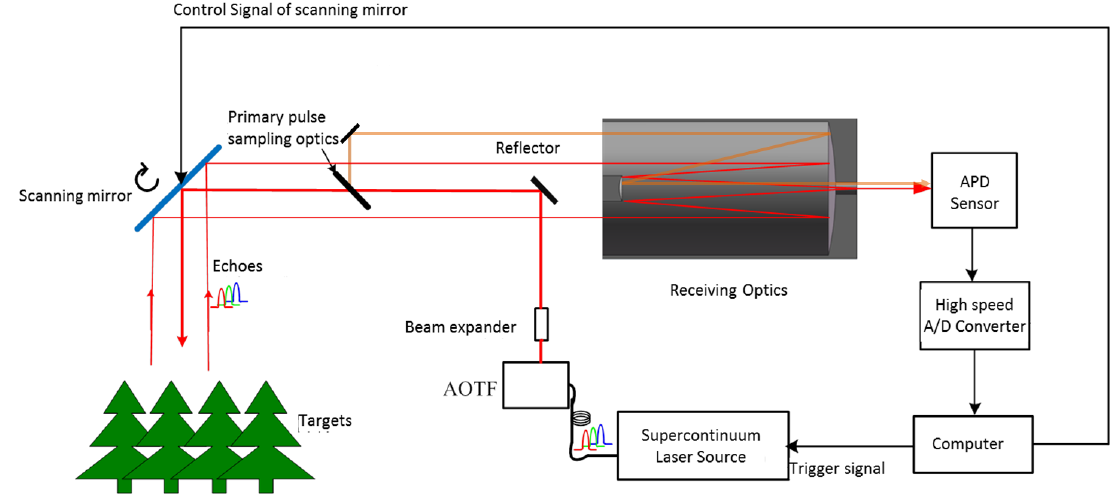
Figure 1. Schematic setup of acousto-optic tunable filter based hyperspectral lidar (AOTF-HSL). Table 1. Specifications of the designed acousto-optic tunable filter based hyperspectral Lidar ( AOTF-HSL).